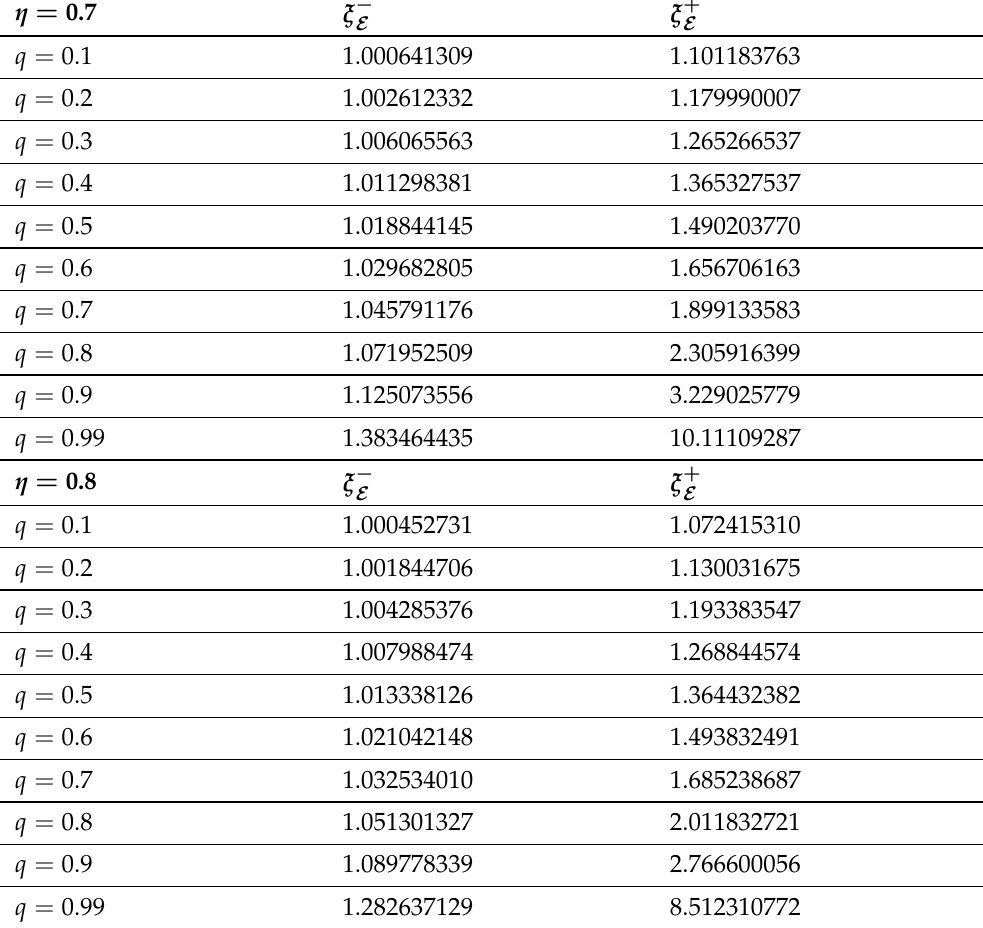
≤ q ≤ 0.99 and 0.7 ≤ η ≤